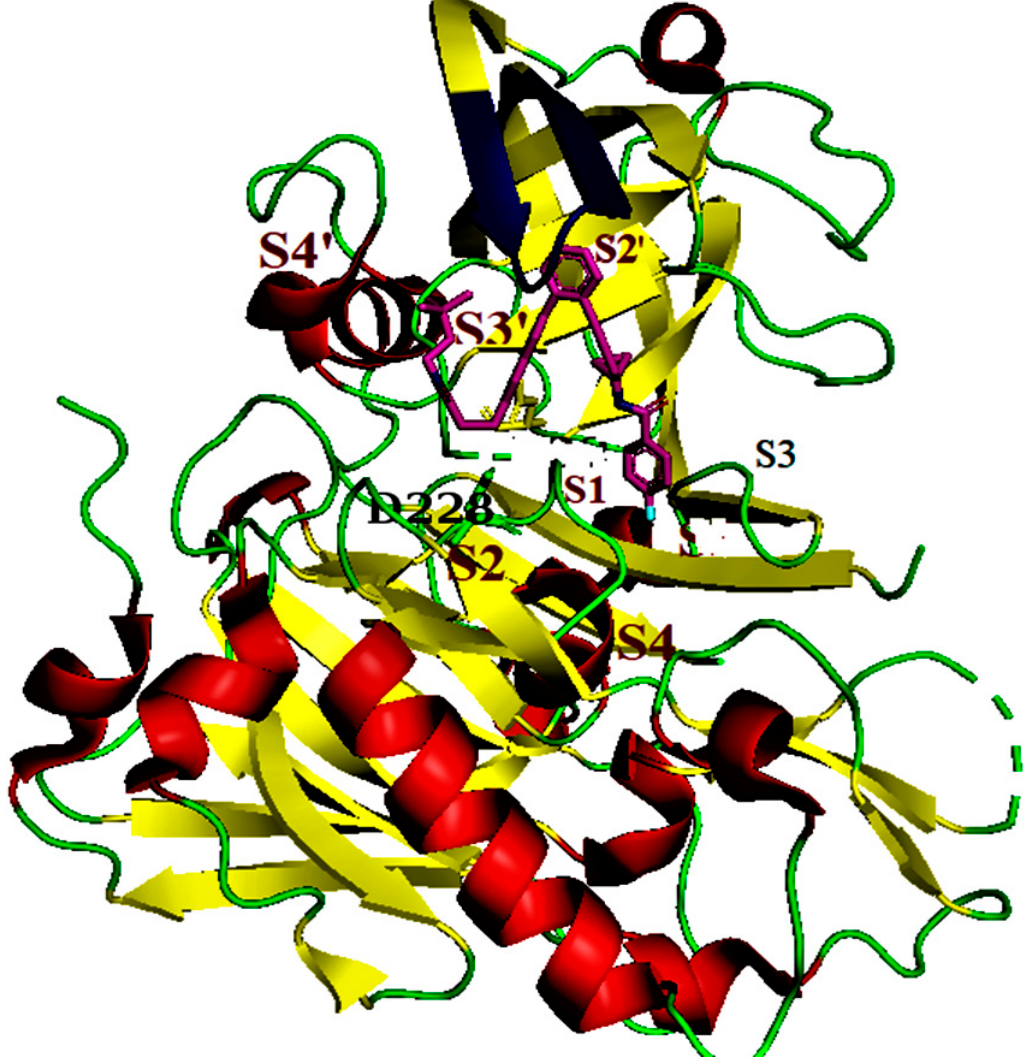
Figure 1. Structures of β -site APP cleaving enzyme-1 (BACE1) in complex with inhibitor 1 (PDB ID 5i3X. The inhibitor 68J (Pink), catalytic dyad D228 and D32, flap (Blue); ß sheets (yellow); coils (green), Inhibitor (pink).